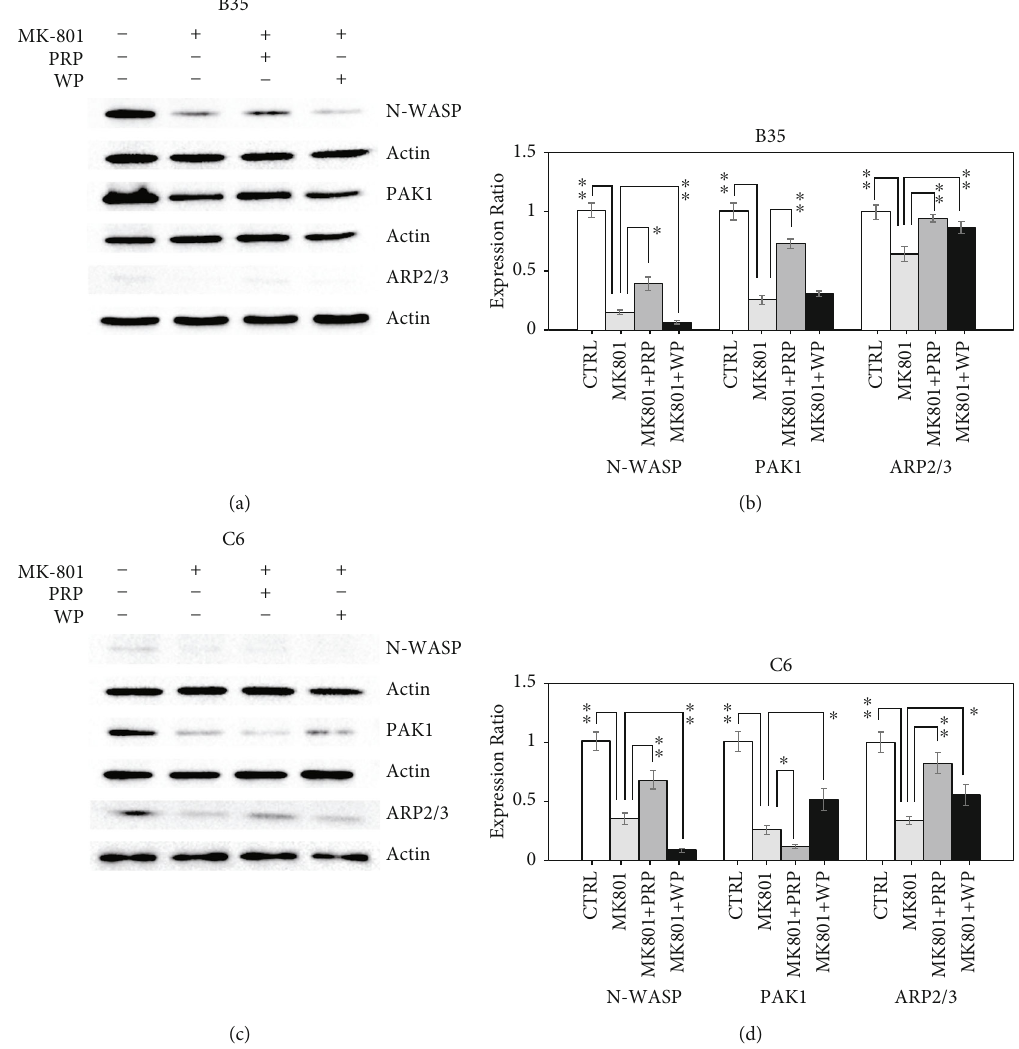
Figure 5: PRP and WP regulate MK-801-induced N-WASP, PAK1, and ARP2/3 regulation. Western blotting revealed the expression changes of the indicated proteins induced by PRP/WP in (a) B35 and (c) C6 cells treated with MK-801. The protein expression was quanti fi ed by using ImageJ software. Beta-actin was used as a normalization control to calculate relative expression of examined target. The bar chart was constructed according to the data of three independent western blot experiments that analyzed three di ff erent batches of protein extracts of drug-treated (b) B35 and (d) C6 cells. The data was analyzed by using Student ’ s t -test ( ∗ p value < 0.05; ∗∗ p value < 0.01)